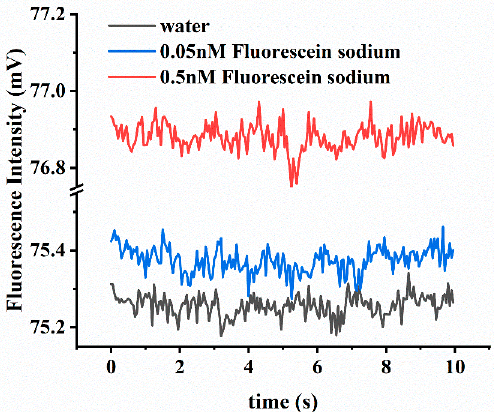
Figure 7. The fluorescence curves of water and sodium fluorescein solutions with concentrations of 0.05 nM and 0.5 nM obtained by the detector.